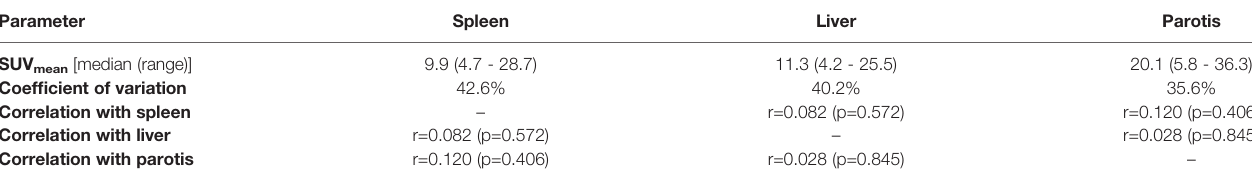
TABLE 4 | Correlation of background tissues SUV liver, SUV parotis & SUV spleen . Parameter